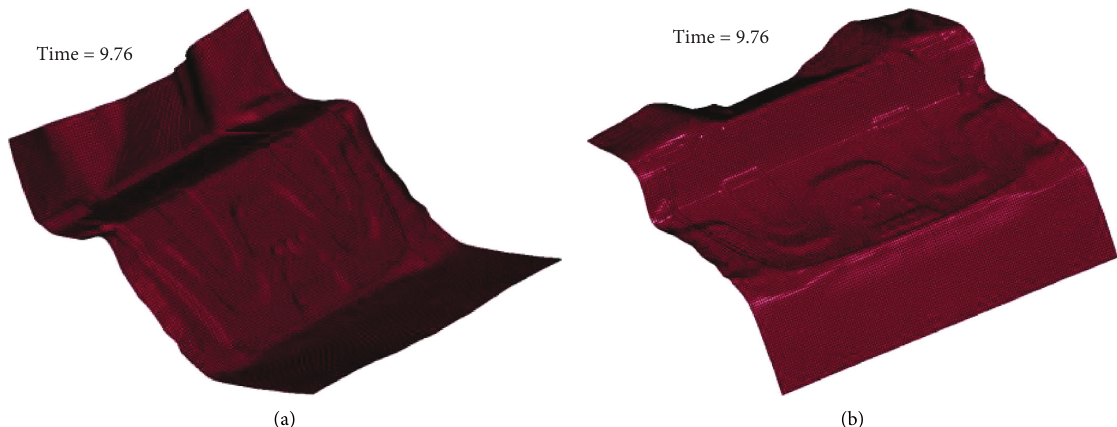
Figure 7: The main body shape of the car coat